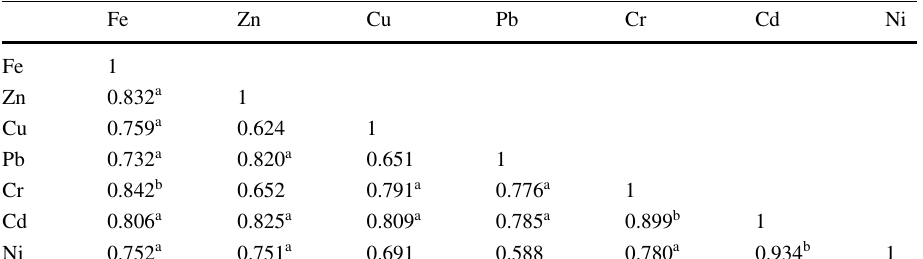
( r ) matrix of heavy metals in Awash River during wet season